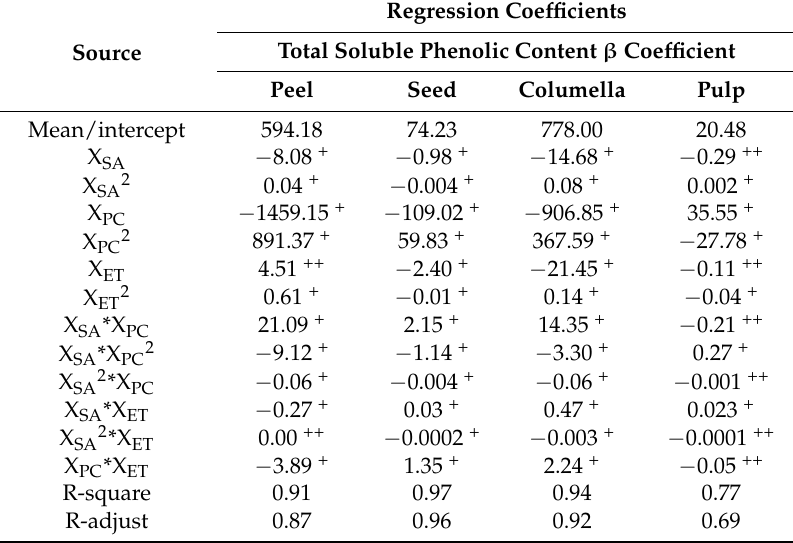
Table 3. Regression coefficients of predicted quadratic polynomial models with the ultrasound-assisted extraction conditions on the soluble phenolic content from Annona muricata peel, seeds, columella, and